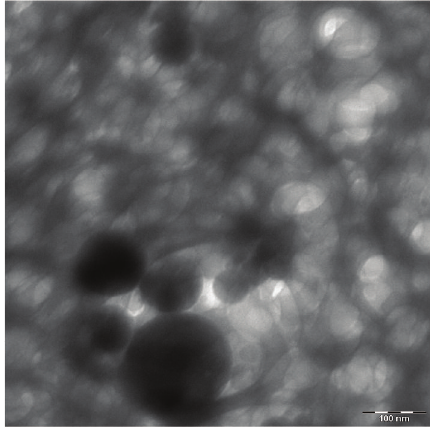
Figure 9: TEM image for CSNC5 (10wt.% of Al 2 O 3 ).